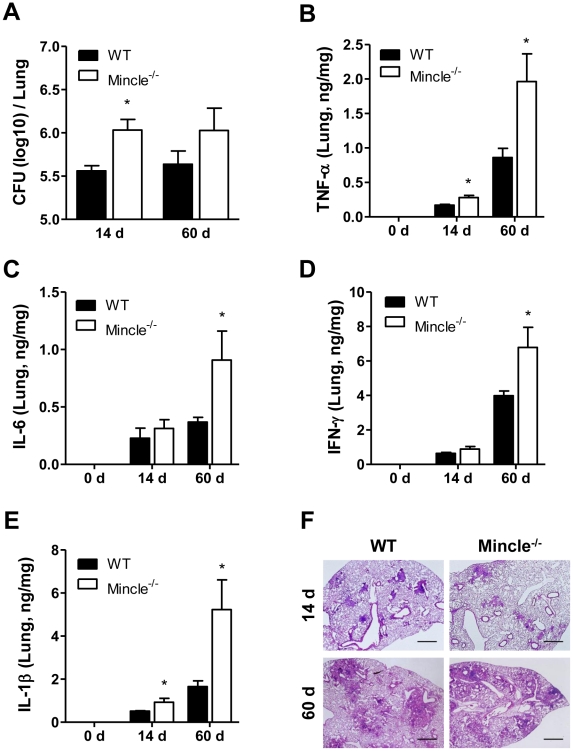
Bacterial loads and cytokine levels are elevated in lungs from Mincle−/− mice following Mycobacterium tuberculosis infection.(A) Viable bacterial numbers in the lungs of wild-type (WT) and Mincle−/− mice (n≥4) were determined at the indicated time points following mycobacterium tuberculosis (Mtb) infection. Mean log colony-forming units (CFUs) per lung (±SEM) are shown. (B–E) TNFα (B), IL-6 (C), IFNγ (D), and IL-1β (E) levels were measured in the lungs of WT and Mincle−/− mice at the indicated time points following virulent Mtb strain Erdman infection. Statistical significance is shown relative to WT for each group. *p<0.05. (F) Histology of Hematoxylin and eosin (H&E)-stained lung tissues from Mtb-infected WT and Mincle−/− mice. Original magnification was 4×. Scale bars represent 500 µm.